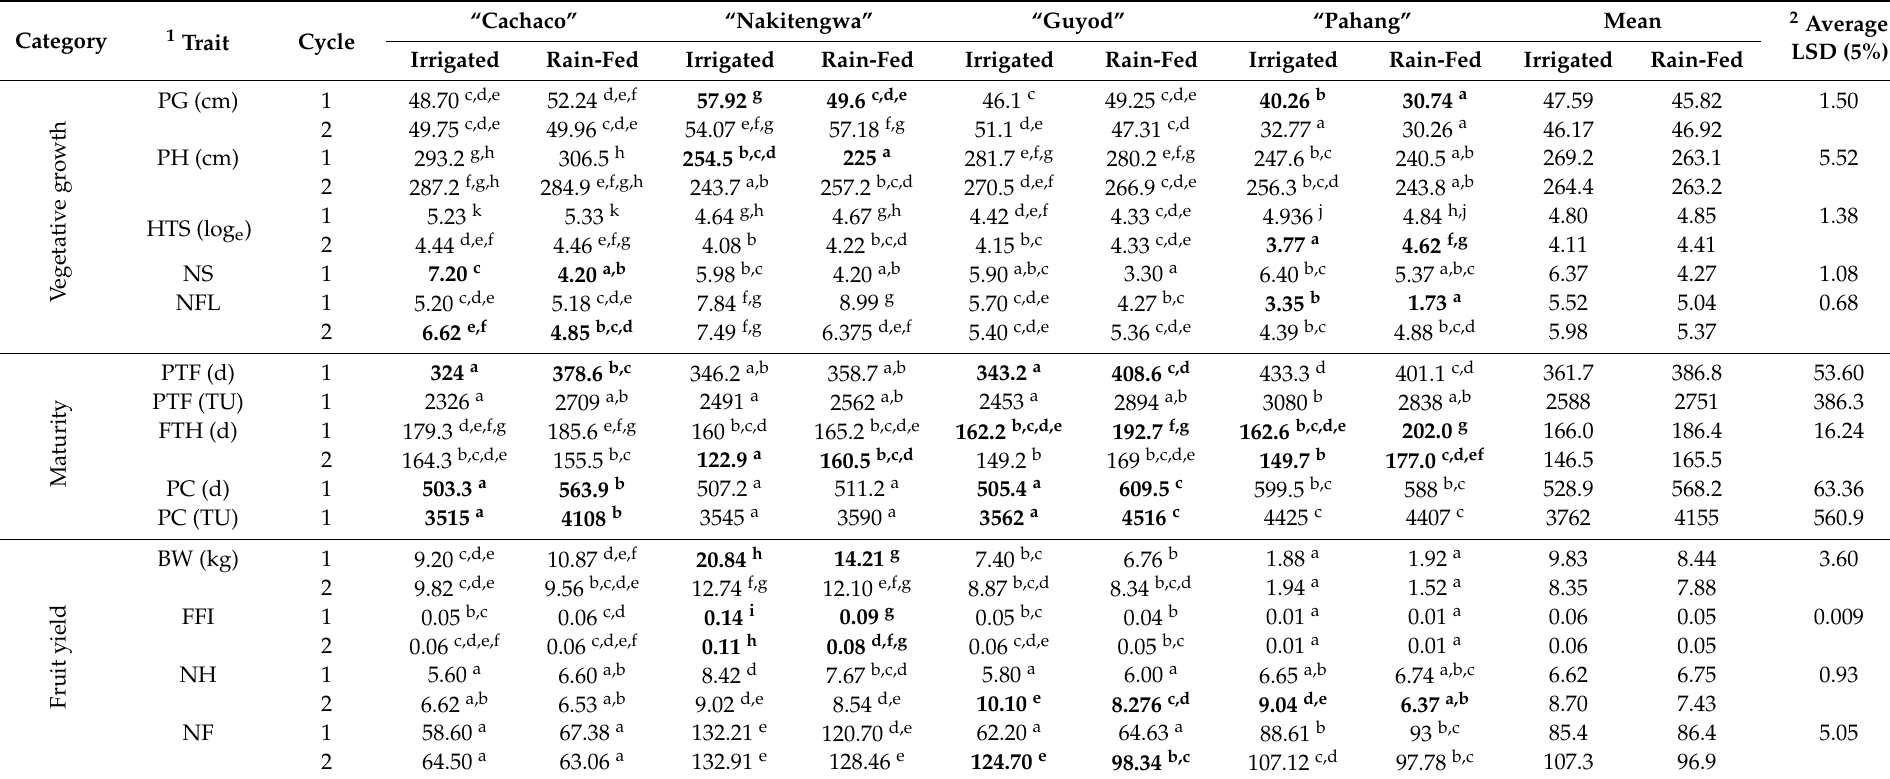
Table 4. Mean separation (ANOVA) for the evaluated agronomic traits comparing the two treatments (irrigated vs. rain-fed) for each genotype and cycle, and their average values in each treatment and